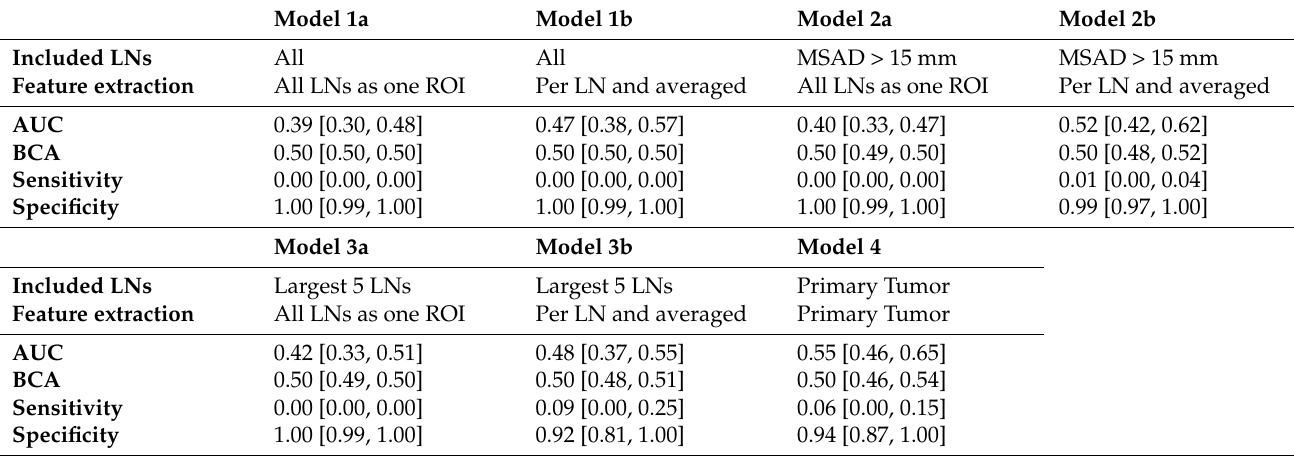
Table 2. Performance of the radiomics models for distinguishing pN+ from pN0 disease in patients with muscle-invasive bladder cancer in the testing datasets. Models are based on: all lymph nodes and combining segmentations per CT scan as one ROI, followed by feature extraction (1a) or extracting features from lymph nodes individually followed by averaging these features per patient (1b); lymph nodes with MSAD > 15 mm, combining segmentations per CT scan as one ROI followed by feature extraction (2a) or extracting features from lymph nodes individually followed by averaging these features per patient (2b); largest five lymph nodes, combining segmentations per CT scan as one ROI followed by feature extraction (3a) or extracting features from lymph nodes individually followed by averaging these features per patient (3b); features extracted from the primary tumor as ROI. Values are mean (95% confidence interval) over the cross-validation